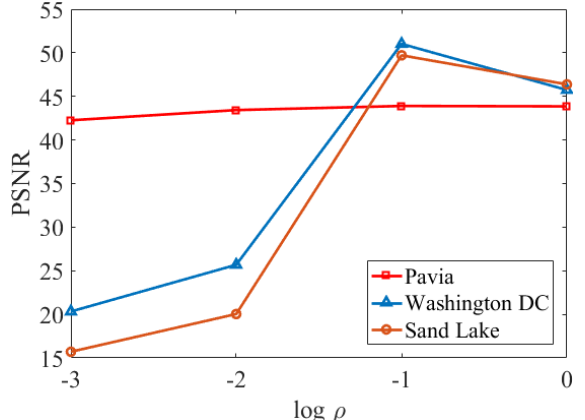
Figure 2. PSNR values for different log ρ .